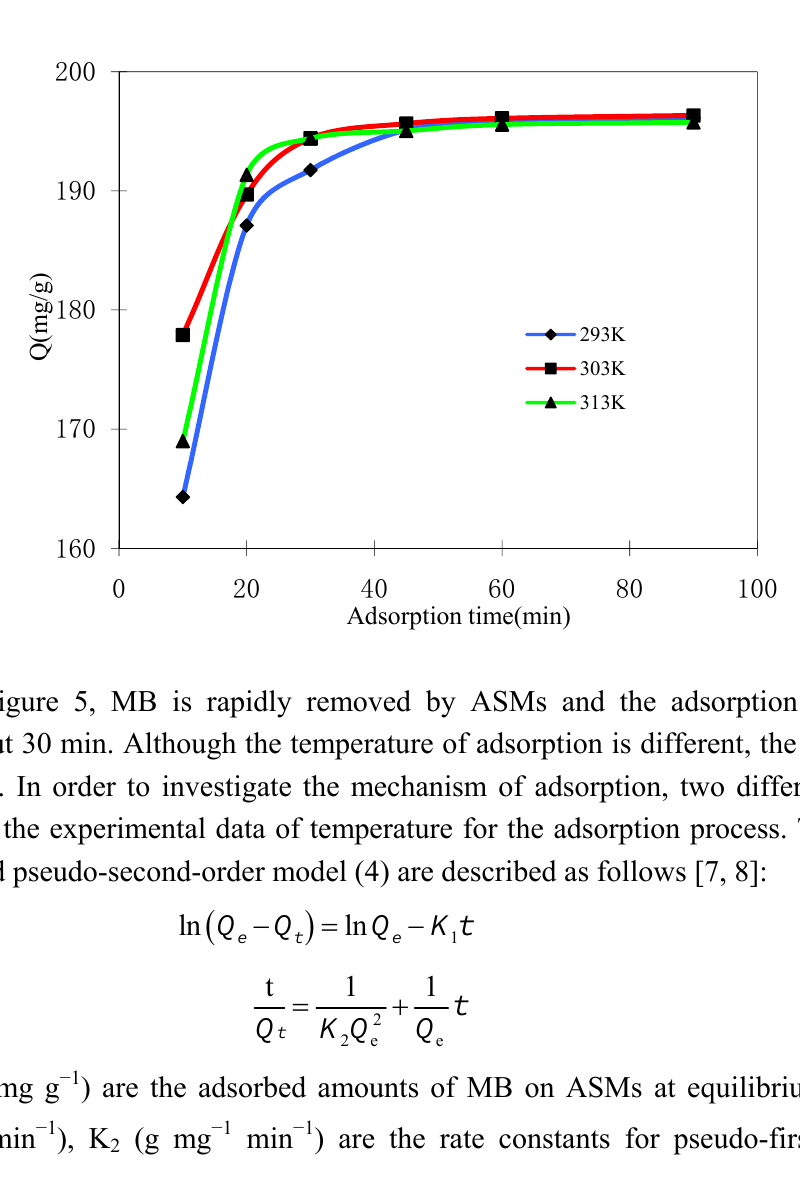
Figure 5. Effect of adsorption time on MB adsorption by ASMs.C